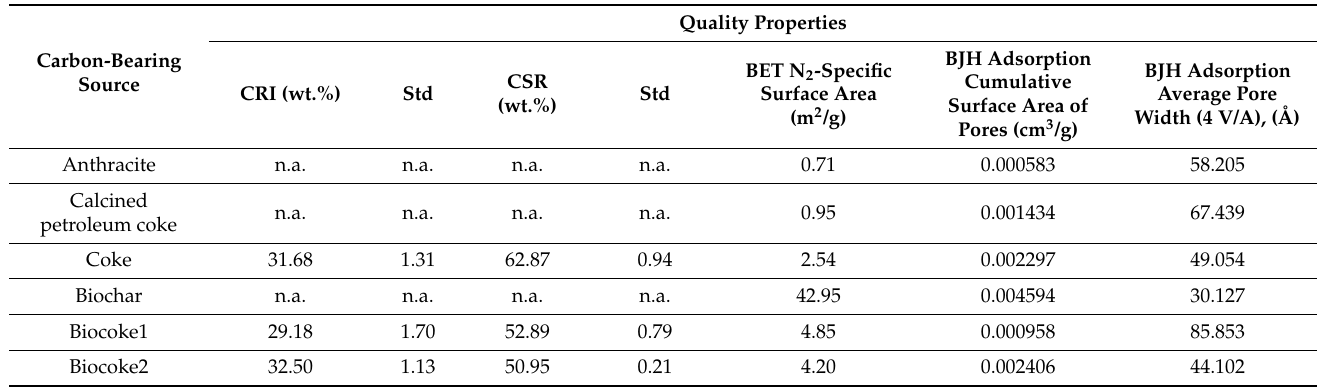
Table 4. The quality properties of carbon-bearing sources.